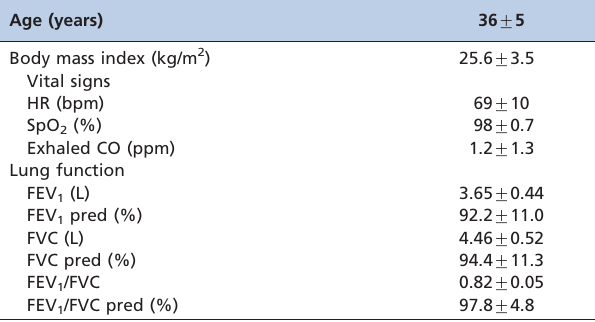
Table 1 - Mean ( ¡ SD) for demographic data, heart rate (HR), pulse oximetry (SpO 2 ), exhaled carbon monoxide (CO) and spirometry data for 25 commercial motorcyclists.